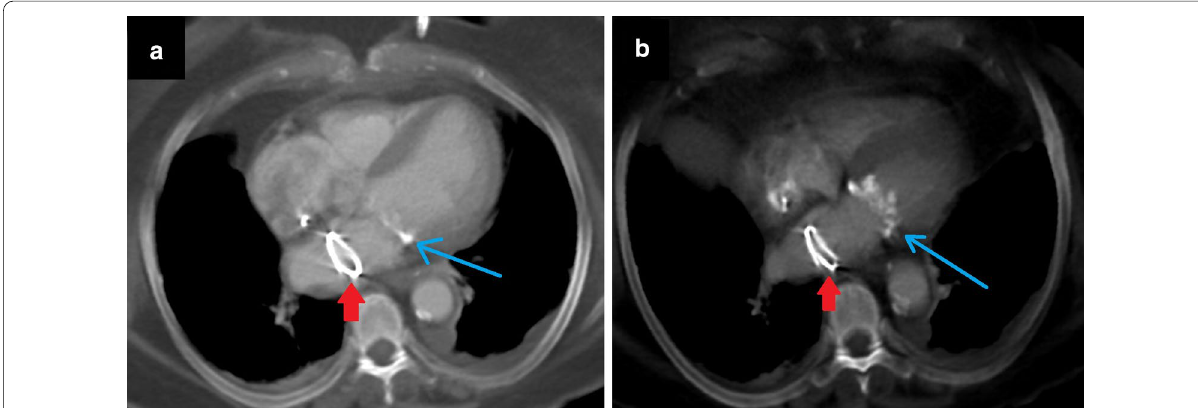
Fig. 25 Importance of effective communication. A 65-year-old female patient suffered from the new onset of dyspnea three days after mitral valve replacement. Thorax CT showed the intra-atrial location of the replaced mitral valve (red arrows, a , b ). When the abnormal valve location and new onset of dyspnea were considered, displacement of the replaced mitral valve was suspected. The cardiovascular surgery department was immediately called to report this situation. After a brief opinion exchange with the referrer, it was learned that this valve location is the expected location in patients who have undergone mitral valve replacement with the Chimney technique, which is preferred for patients with extensive mitral annular calcifications (blue arrows, a , b ) to prevent calcified embolism during the procedure. As a result, effective communication